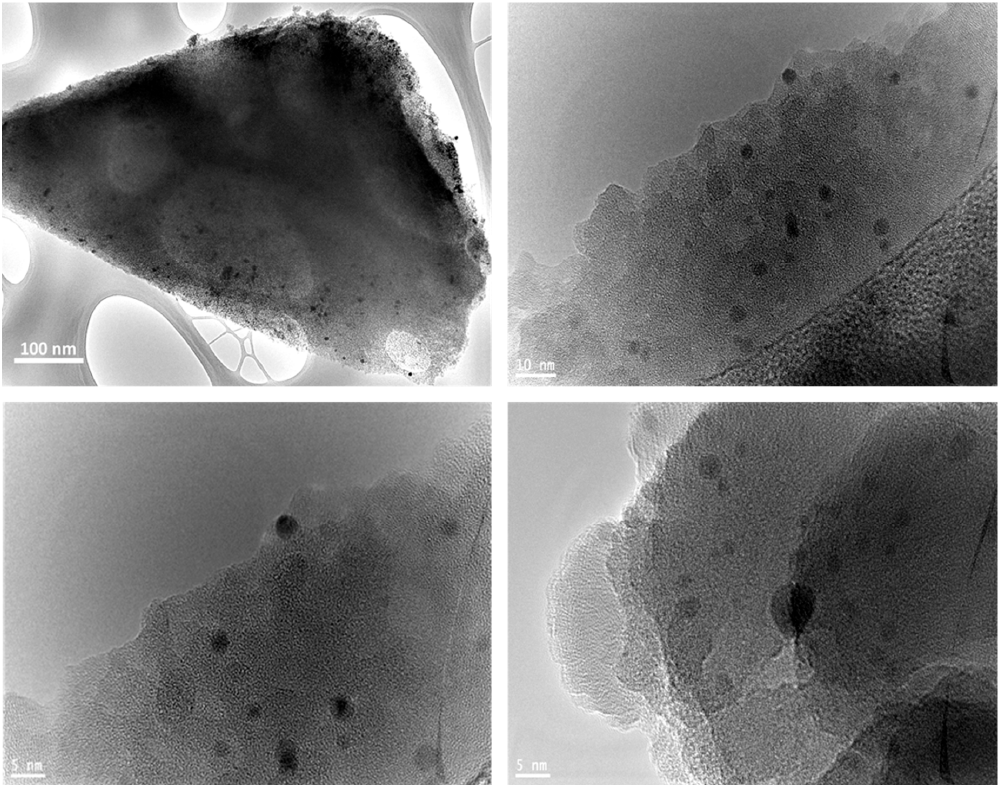
Figure 4. HR-TEM micrographs of the Rh-1 sample.